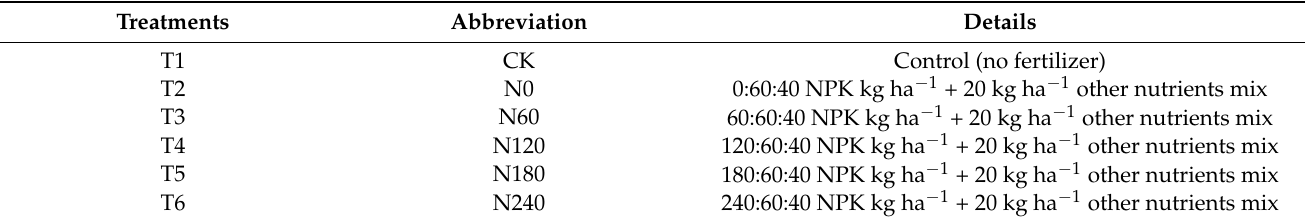
Table 1. Details of different treatments with various N levels used in the study.